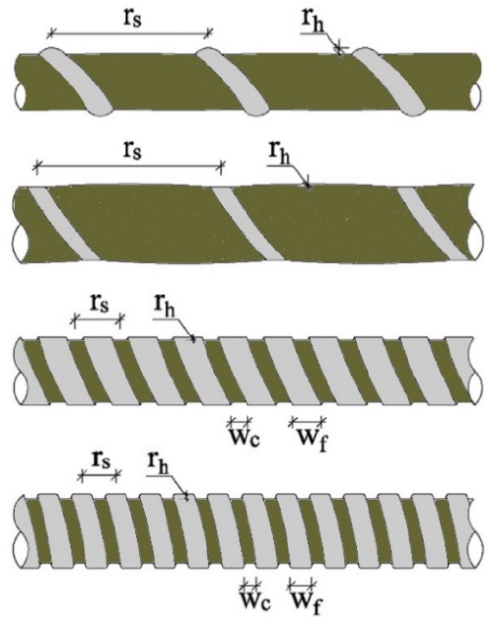
Figure 4. FRP bar rib height and spacing (modified from Figure 5. FRP bar rib height and spacing (modified from [36]). Table 3. Studies on the influence of surface type on FRP–concrete bond strength.